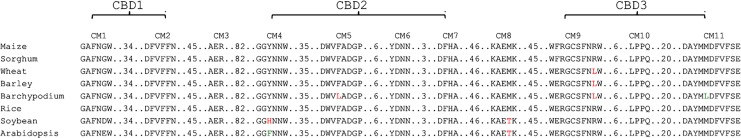
Novel conserved motif (CM) identified in the carbohydrate-binding domain (CBD) of starch synthase among monocot and dicot species.Conserved regions are in black, synonymous changes in green and non-synonymous changes in red. Number represents the distance between the two CMs in terms of amino acids.